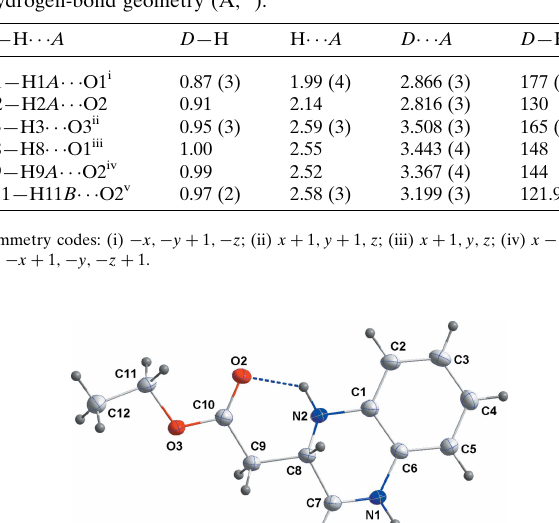
Table 2 Experimental